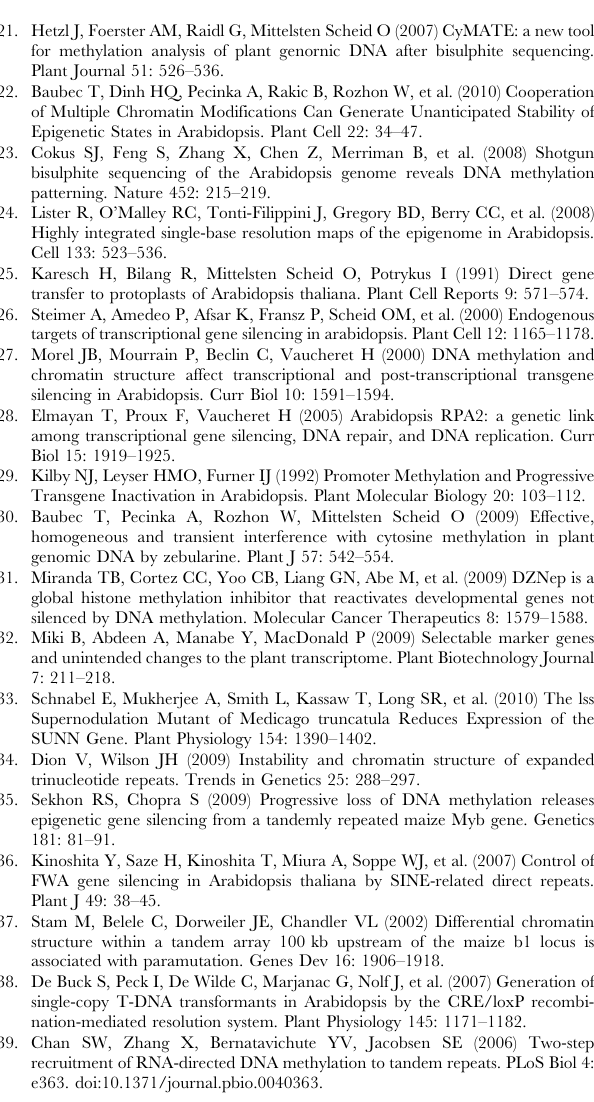
Figure 1A). (C,D) Probe recognizing also P2 transcript (NC, Figure 1A). (E,F) U6 probe as a control for poly(A)-enrichment, excluding contamination with total RNA. Figure S7 Analysis of cis -mutants for effects on global methyl- ation and trans-activation. (A) Global cytosine methylation levels were measured by HPLC after hydrolysis of genomic DNA. (B) Line 5 with a transcriptionally silent GUS gene was crossed with the c is -mutants and F2 plant homozygous for the mutations analyzed for GUS expression. S, inactive epiallele; R, active epiallele; W, wild type; ddm1 , mutant known to reduce global methylation and to trans-activate GUS. Table S1 Normalization of small RNA libraries using Bowtie. (PPT) Table S2 Distribution of small RNAs. (PPT) Table S3 Summary of small RNAs reads in epialleles. (PPT)